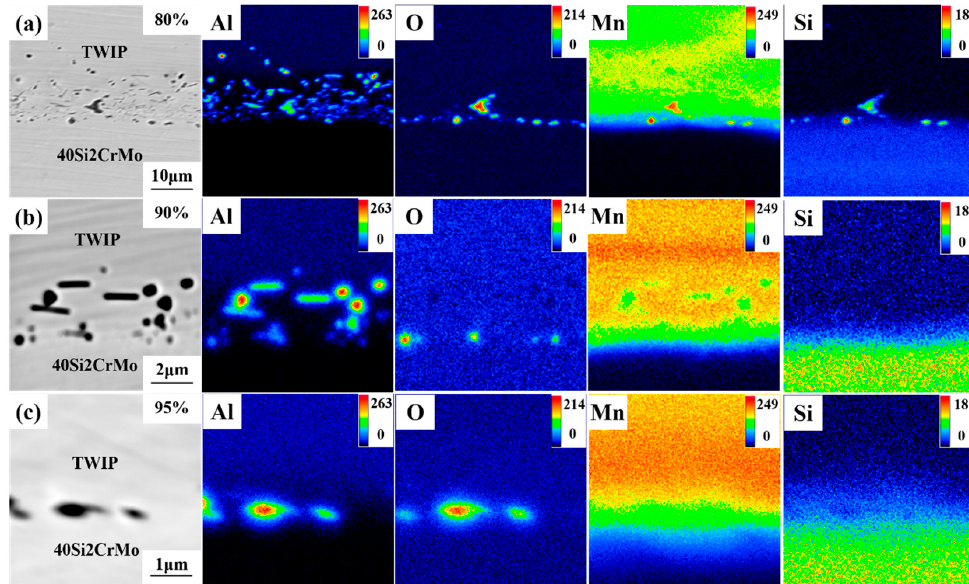
Figure 5. EPMA surface scanning of the element distributions of multilayer TWIP/40Si2CrMo steels with different hot rolling reductions: ( a ) 80%; ( b ) 90%; ( c ) 95%.